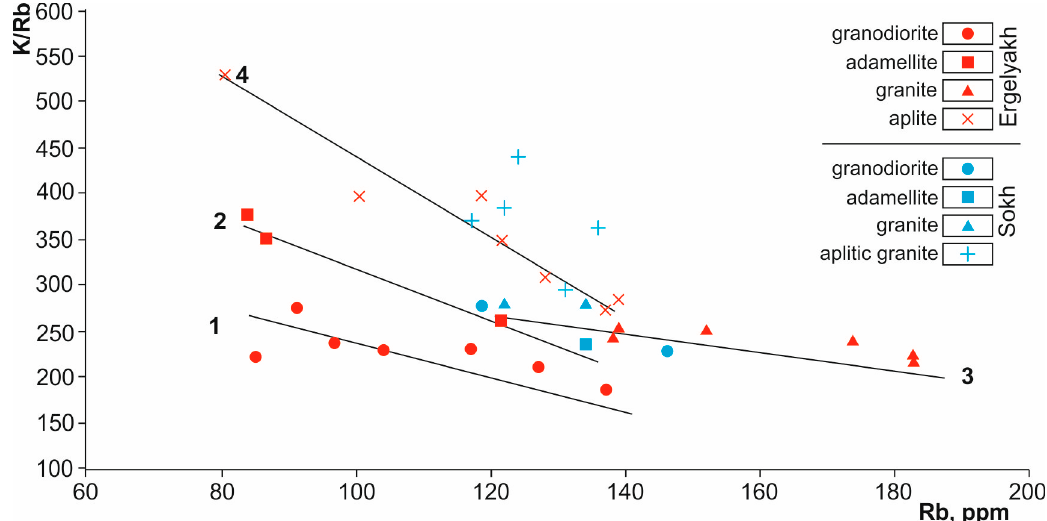
Figure 6. Rb–K / Rb diagram for granitoids of Ergelyakh and Sokh massifs. 1–4—trend lines for granitoids: Figure 6. Rb–K/Rb diagram for granitoids of Ergelyakh and Sokh massifs. 1–4—trend lines for 1—granodiorite, 2—adamellites, 3—granites, 4—aplites and aplitic granitoids: 1—granodiorite, 2—adamellites, 3—granites, 4—aplites and aplitic granites.